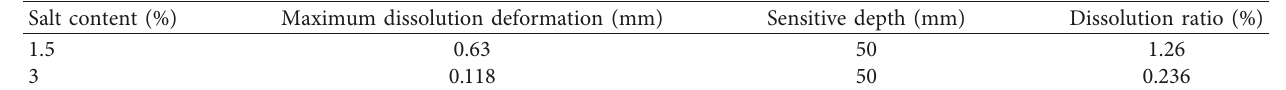
Table 5: Dissolution ratio of saline soil with different salt contents.